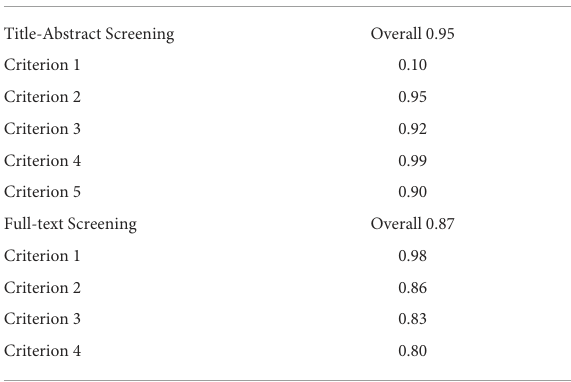
TABLE 2 Proportional agreement of the inter-rater reliability at each screening stage.